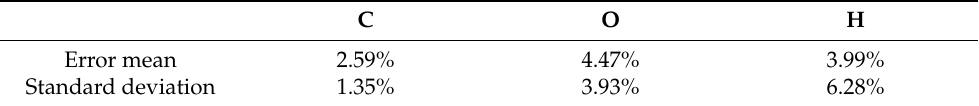
Table 6. Error mean and standard deviation.